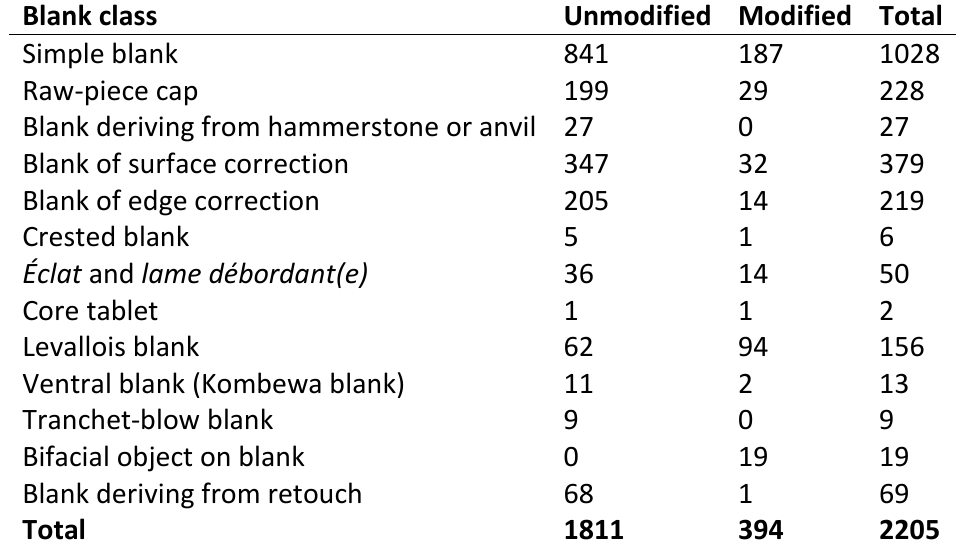
Table 10. Numbers of unmodified and modified blanks per blank class (without cores-on-blanks). Blank